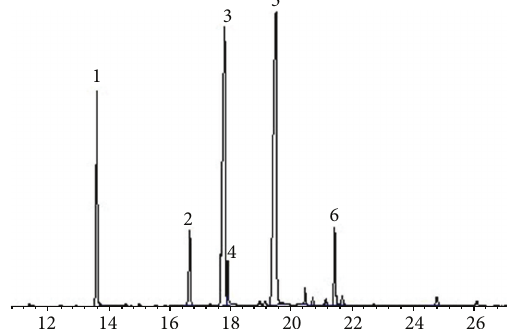
Figure 5: Typical chromatogram of fatty acid methyl ester prepared from EAEPO after heating. Peaks: 1: hexadecanoic acid; 2: octade- canoic acid; 3: 9-octadecenoic acid; 4: 9-octadecenoic acid; 5: 9,12- octadecadienoic acid; 6: 12,15-octadecadienoic acid.